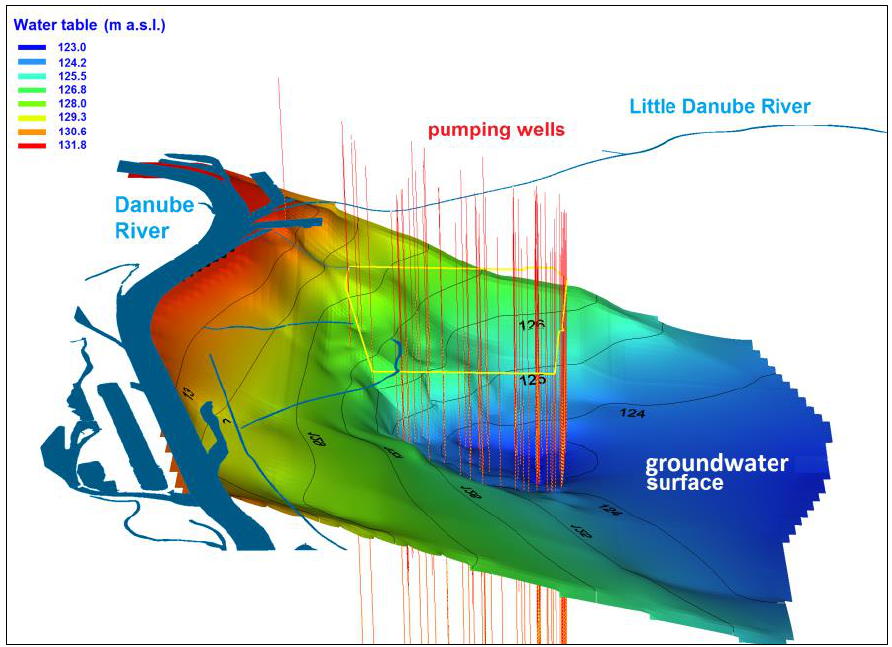
Figure 9. Resulting groundwater table of the V4 model variant, hydroizohypses, bodies of surface water, refinery area border, and pumping wells’ location in the 3D modeled site view.